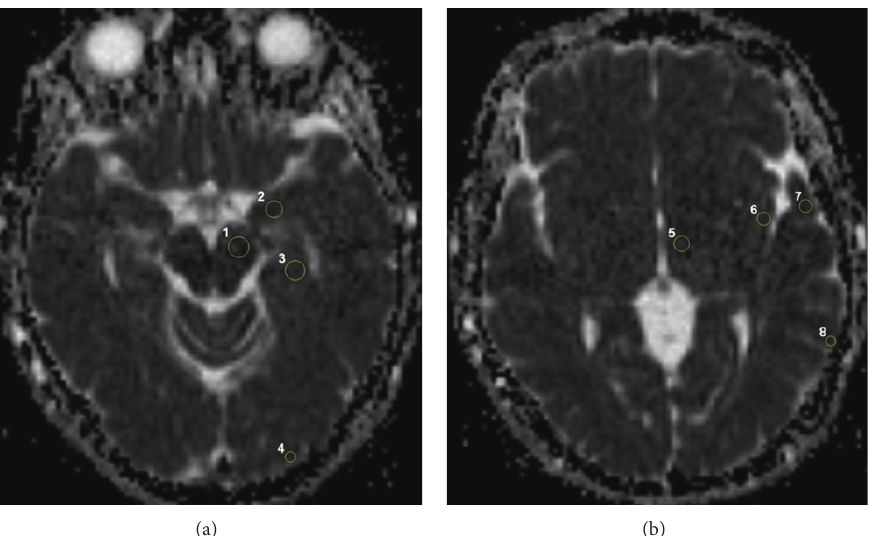
Figure 1: ADC maps show several ROIs: midbrain (1), amygdala (2), hippocampal gyrus (3), and occipital cortex (4) on (a); hypothalamus (5), insular (6), middle temporal (7), and parietal cortices (8) on (b).